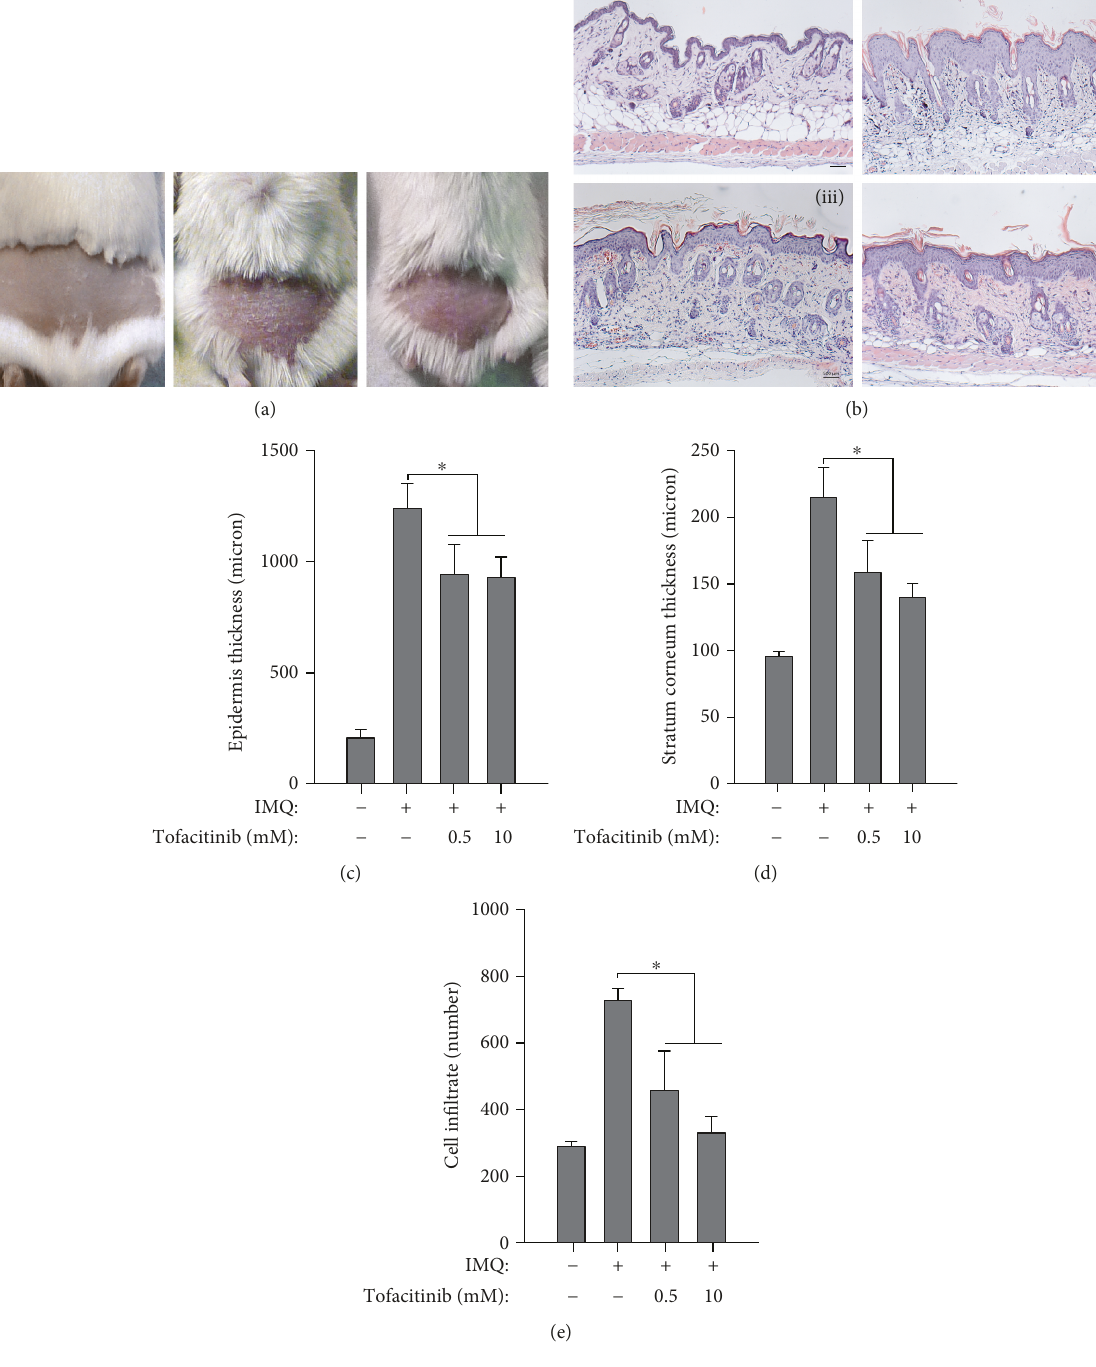
Figure 4: Tofacitinib inhibits in fl ammatory responses in the IMQ-induced psoriasiform mouse model. (a) Representative pictures of back- shaved mice left untreated (left), IMQ-treated (middle), or undergoing to cotreatment with IMQ and 10mM tofacitinib. (b) Representative H&E staining of (i) untreated, (ii) treated with IMQ cream, and in the presence of 10 mM (iii) or 0.5mM (iv) tofacitinib. Mouse skin treated with IMQ reverted their condition after tofacitinib topical application of 0.5 and 10 mM. The quanti fi cation of (c) epidermal, (d) scale thickness, and (e) cell in fi ltrate number was analysed as parameters of skin acanthosis and in fl ammation. Graphs show means of microns of epidermis and stratum corneum thickness and mean of number of cells in fi ltrating dermis per section, ± SD per group ( n = 10 mice). ∗ p < 0 001